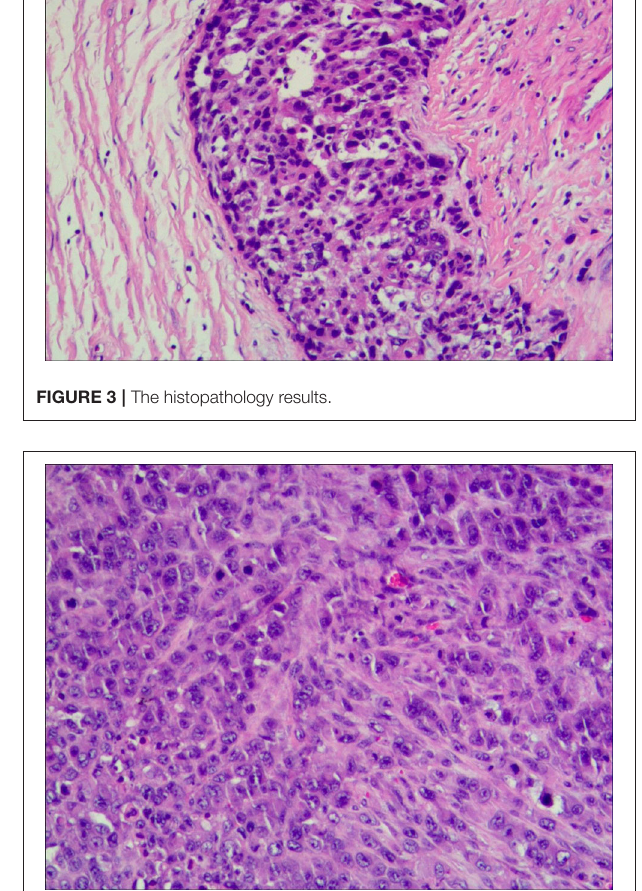
FIGURE 4 | The tumor cells are arranged in